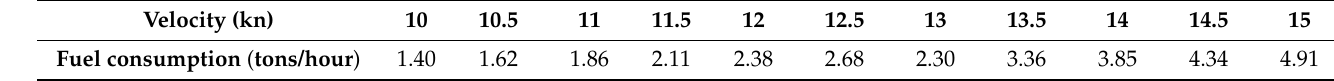
Table 3. Ship speed and fuel consumption data.